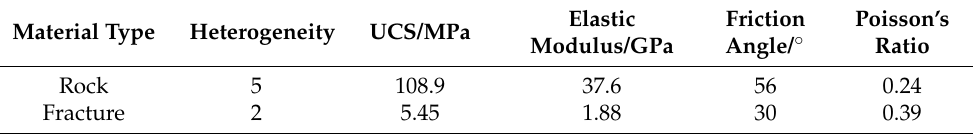
Table 1. Mechanical parameters of the rocks and fractures in the study area [24,27].